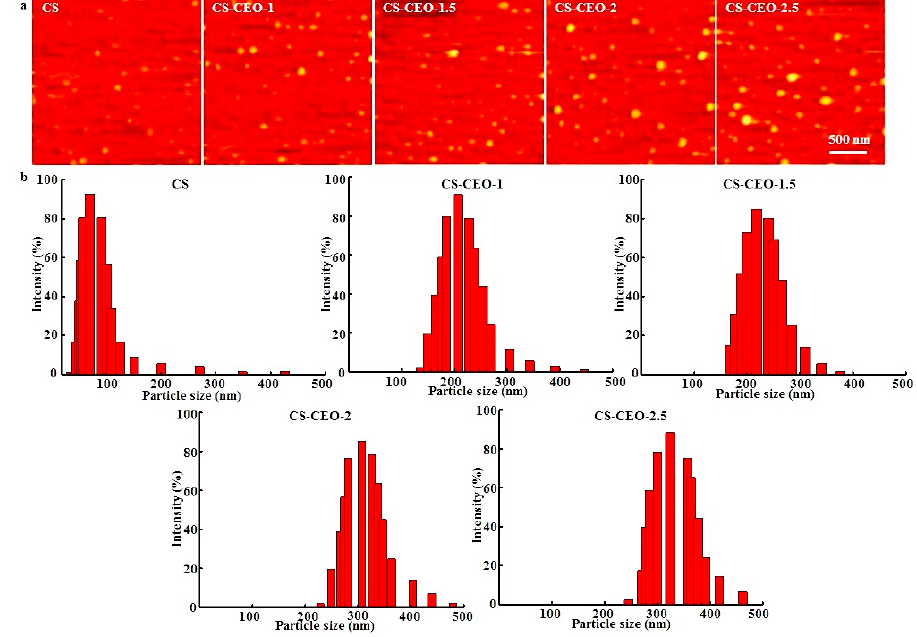
Figure 2. Characterization of CS-CEO nanoparticles. ( a ) AFM image and ( b ) particle size distribution of the CS-CEO particles with different CEO concentrations.